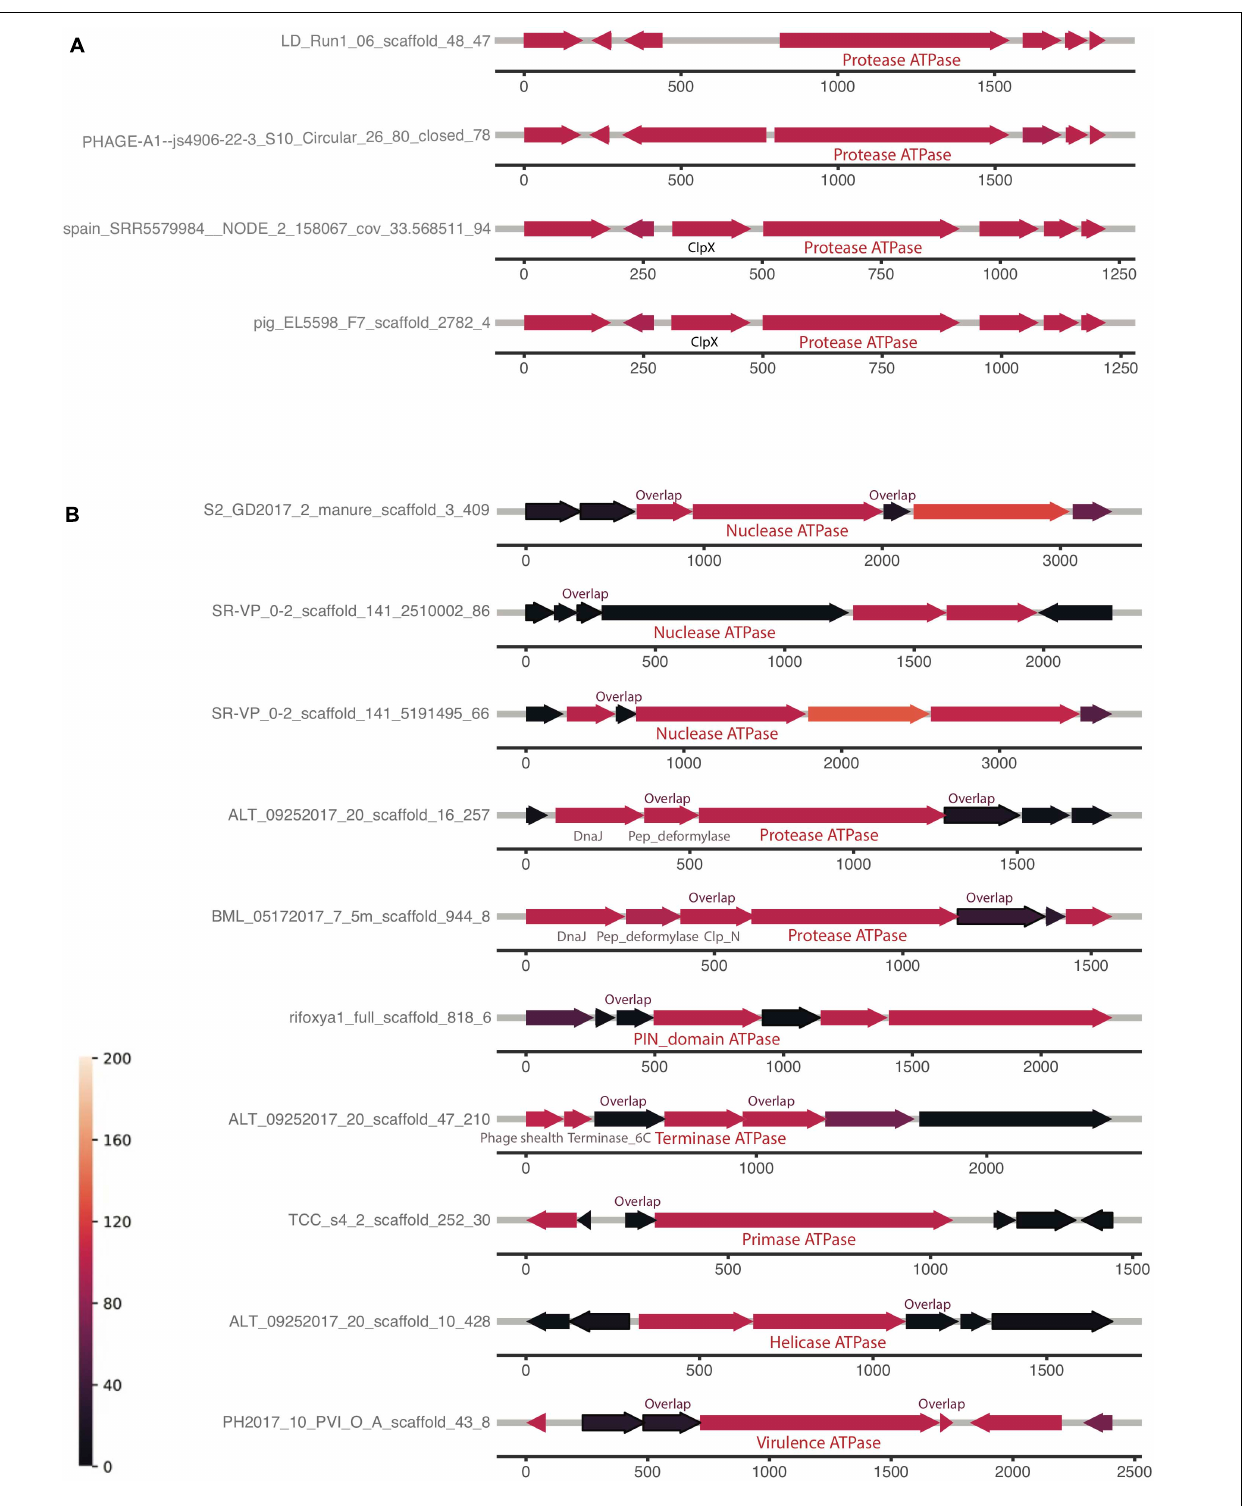
FIGURE 5 | Examples of genomic neighborhood of composite ATPase proteins, with the proteins localized ± 3 of each composite ATPase protein indicated in the middle. Most proteins are unannotated and hypothetical proteins, except those with labels. Identical to the genomic neighborhood heatmap, the color represents the number of blast hits in the ggKbase database. (A) Composite ATPase proteins that are found to have highly conserved operons (indicated with green stars in Supplementary Figure 5B ). (B) Composite ATPase proteins that are found to have highly conserved pairs with a sequence overlap (indicated with blue stars in Supplementary Figure 5B